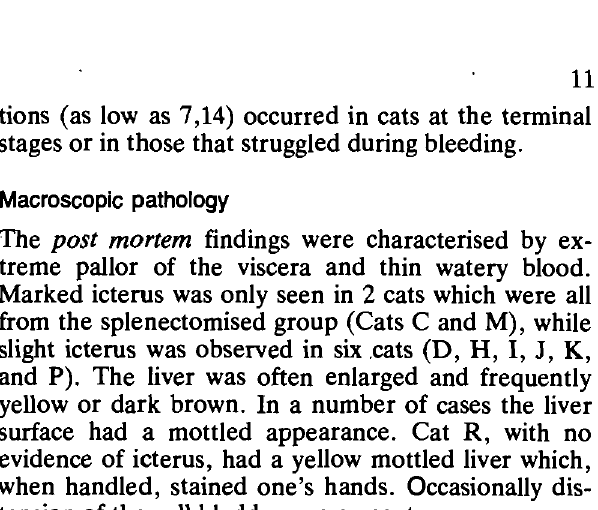
Table 20: CHANGES IN SERUM CREATININE (/-Lmol/t') IN SPLENECTOMISED CATS FROM DAY OF INOCULATION (DAY 0) WITH B. Felis